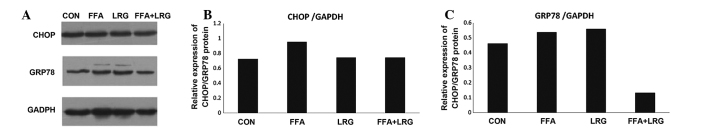
Endoplasmic reticular stress is involved in the activation of autophagy of INS-1 cells induced by LRG. INS-1 cells were treated with normal saline (CON), FFA, LRG and FFA + LRG for 24 h. (A) CHOP and GRP78 proteins were detected using immunoblotting, the results were normalized to that of GAPDH. Quantification of the expression levels of (B) CHOP and (C) GRP78. LRG, liraglutide; CON, control; FFA, free fatty acids.